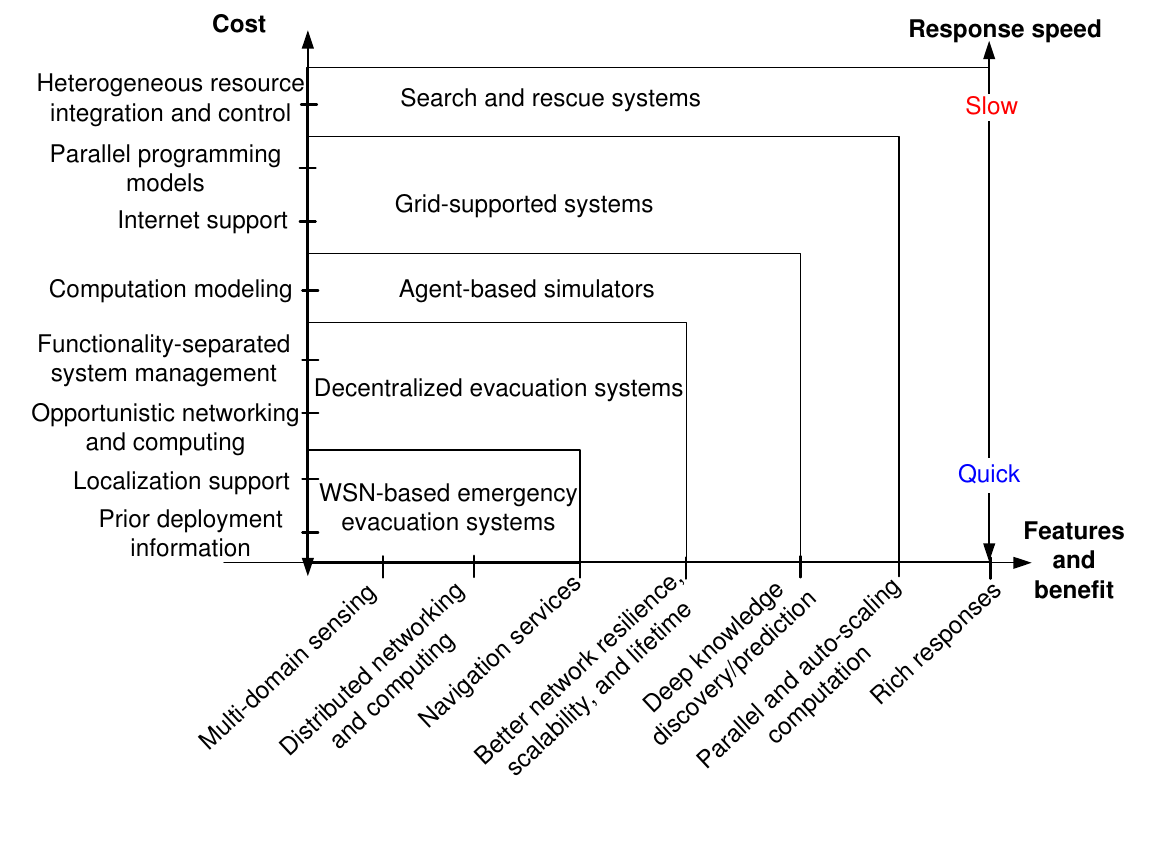
Figure 1. A cost-benefit analysis of emergency response systems.